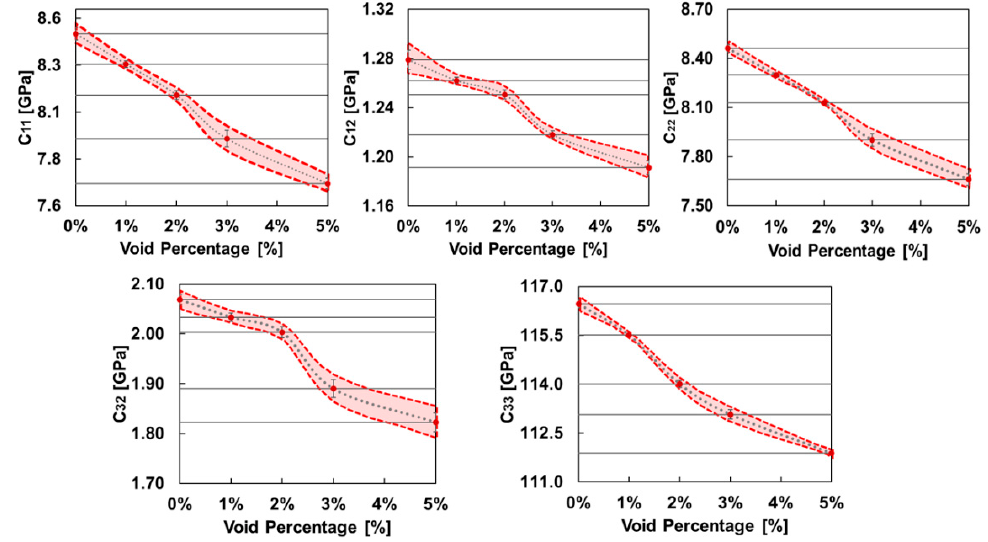
Figure 11. Effective material properties for different types of microvoids. Table 3. Failure loads of unidirectional plates with different hole orientations and fiber directions obtained by the tensile